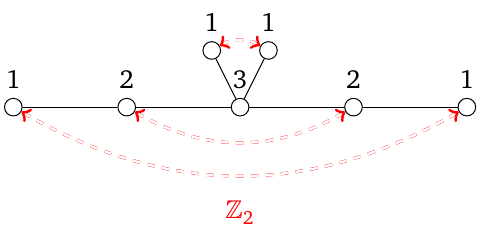
Figure 6: Magnetic quiver for SQCD with gauge group (cid:221) SU ( 3 ) red dashed lines show the (cid:90)